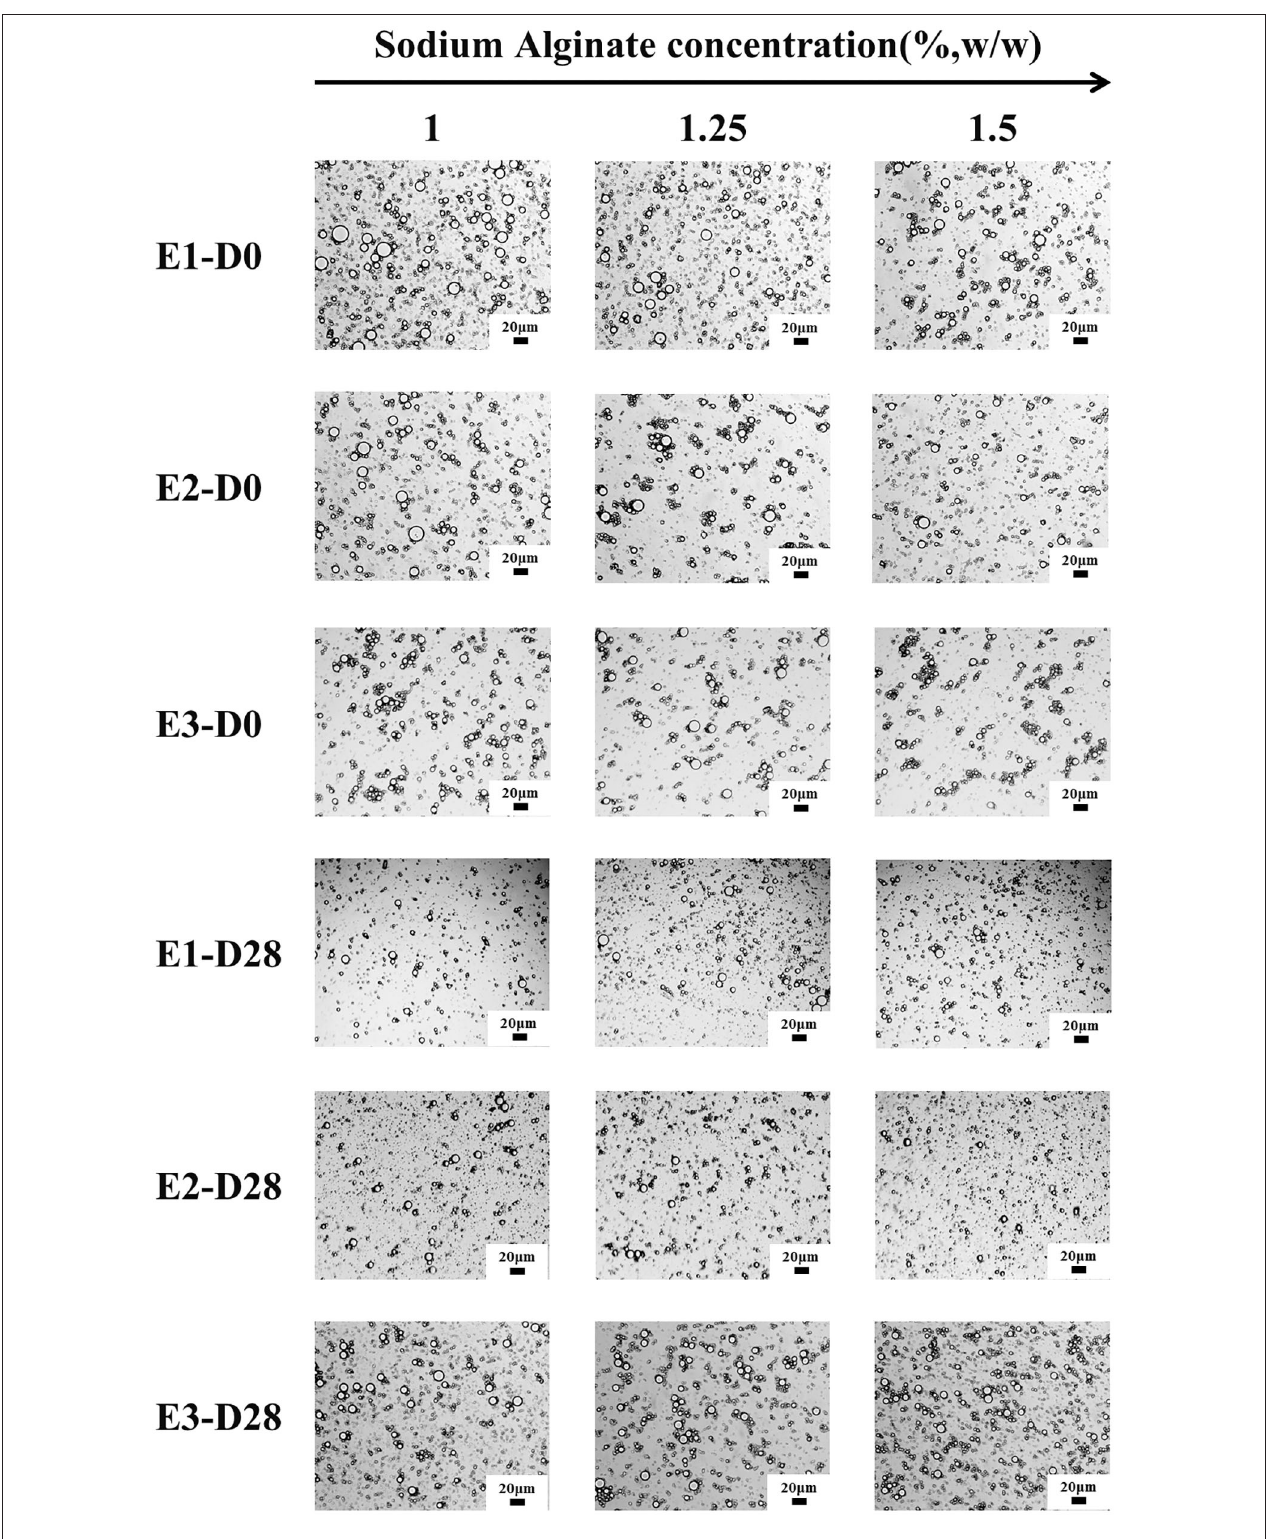
FIGURE 2 | Optical microstructure images of E1–E3 emulsions at different storage times (scale bar is 20 µ m). D0 and D28 represent emulsions stored for 0 and 28 days.